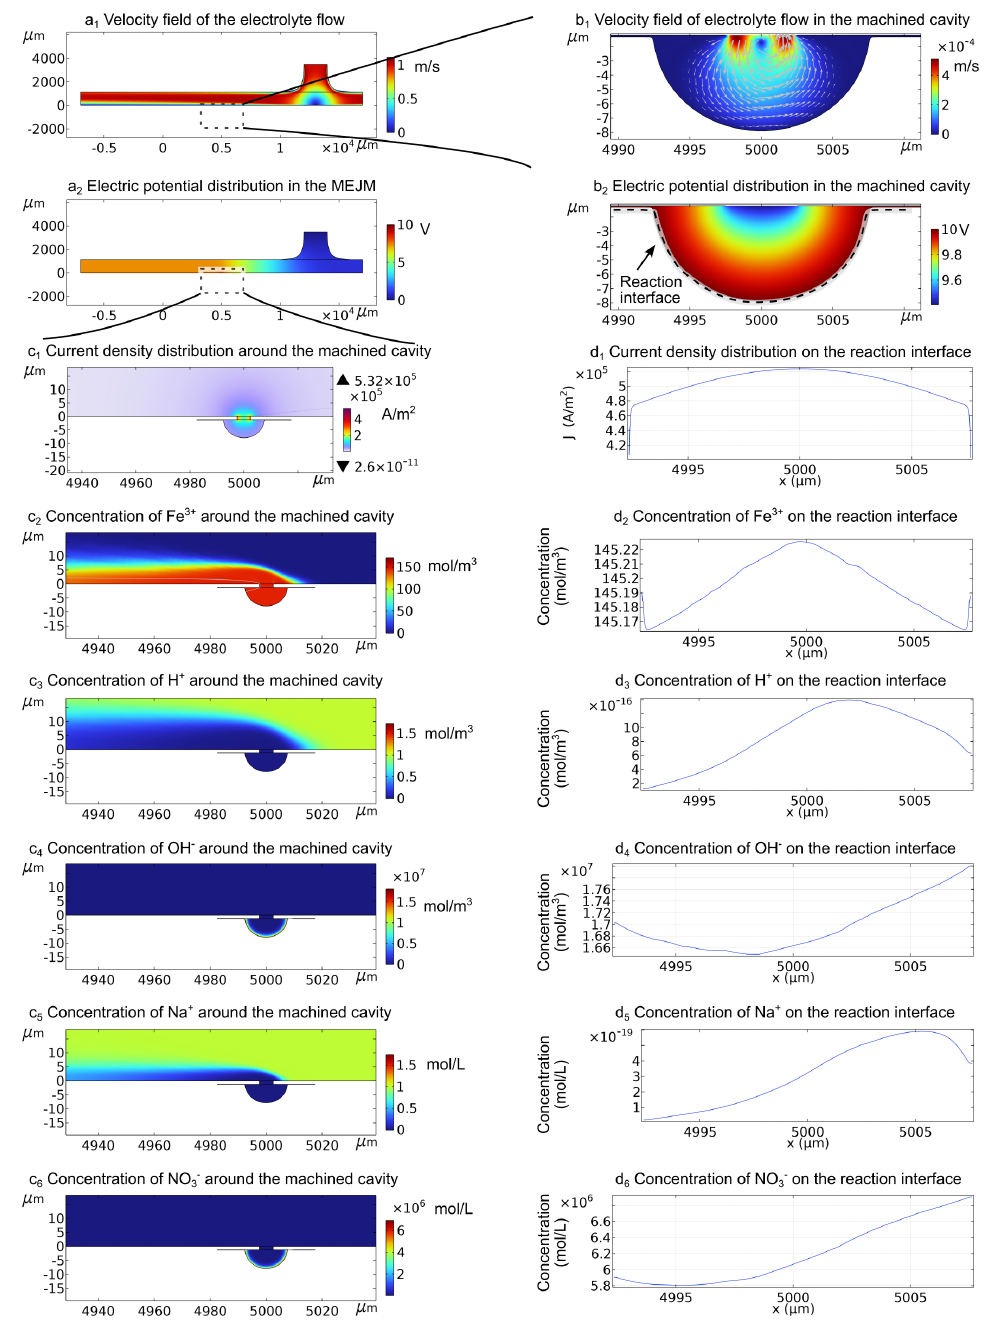
Figure 3. Simulation results at t = 4 s. ( a 1 ): velocity field of the electrolyte flow; ( b 1 ): velocity field of electrolyte flow in the machined cavity; ( a 2 ) electric potential distribution in the MEJM; ( b 2 ) electric potential distribution (V) in the machined cavity; ( c 1 ) normal current density distribution around the machined cavity; ( d 1 ): normal current density distribution on the reaction interface; ( c 2 – c 6 ): concentration ( mol/m 3 ) of Fe 3+ , H + , OH – , Na + , and NO 3– around the machined cavity; ( d 2 – d 6 ): concentration (mol/m 3 ) of Fe 3+ , H + , OH – , Na + , and NO 3– on the reaction